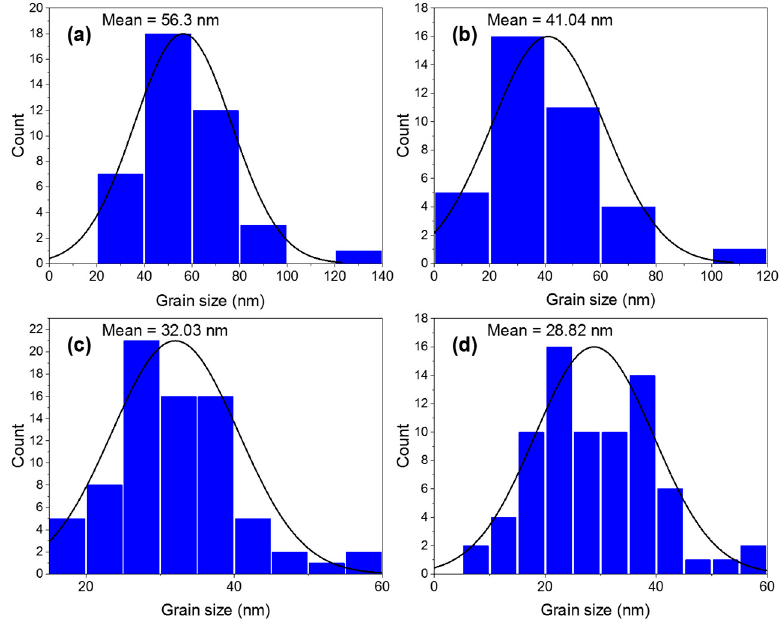
Figure 3. Histograms of ( a ) 0.0, ( b ) 0.01, ( c ) 0.03, and ( d ) 0.05 for Yb and Ce co-doped ZnO